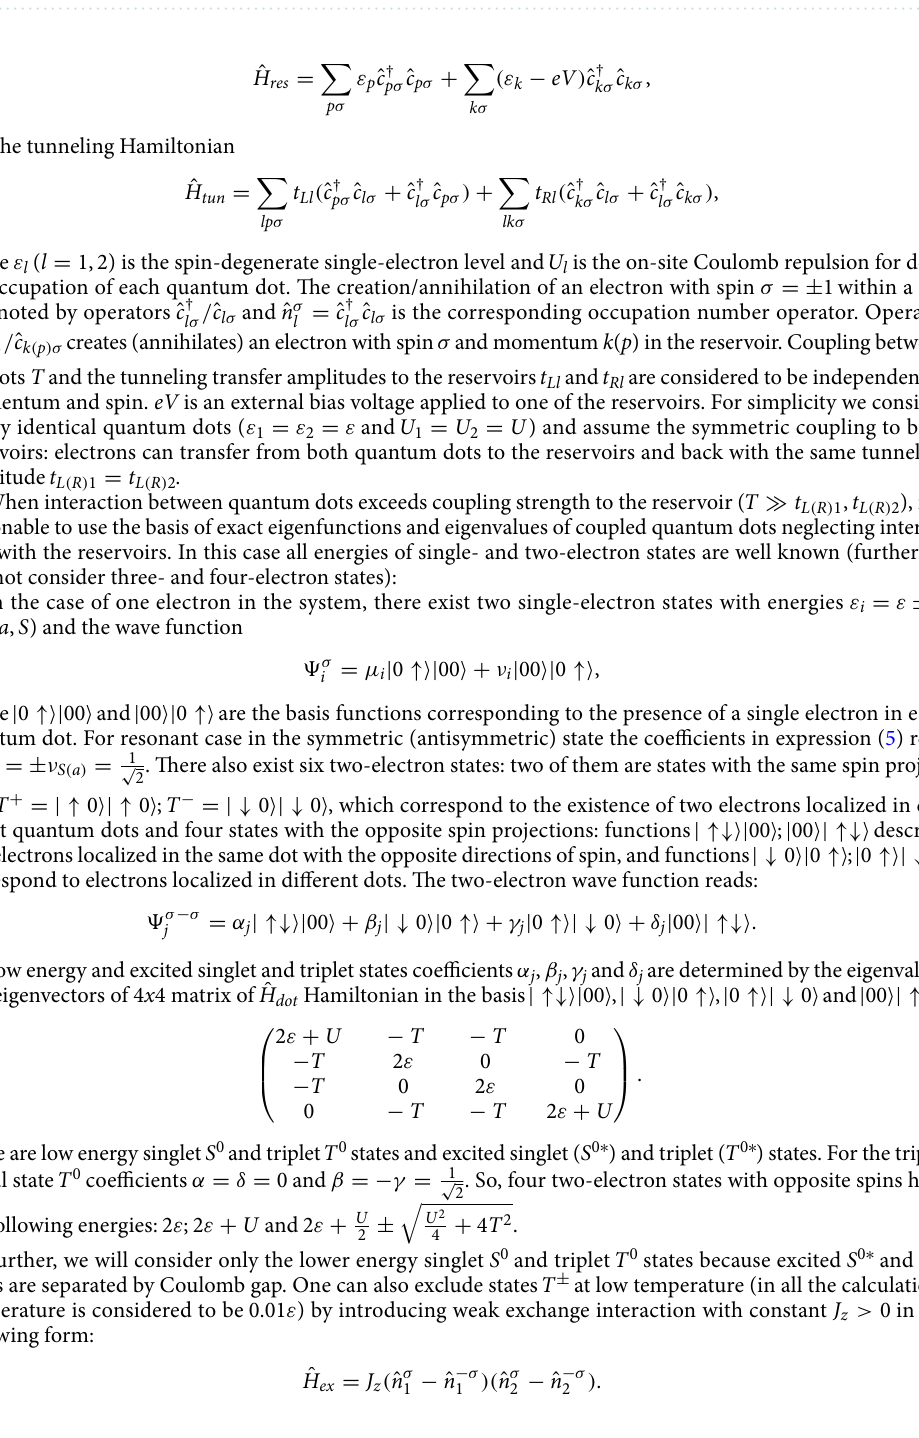
Figure 1. Scheme of two interacting quantum dots (impurity atoms) symmetrically coupled to